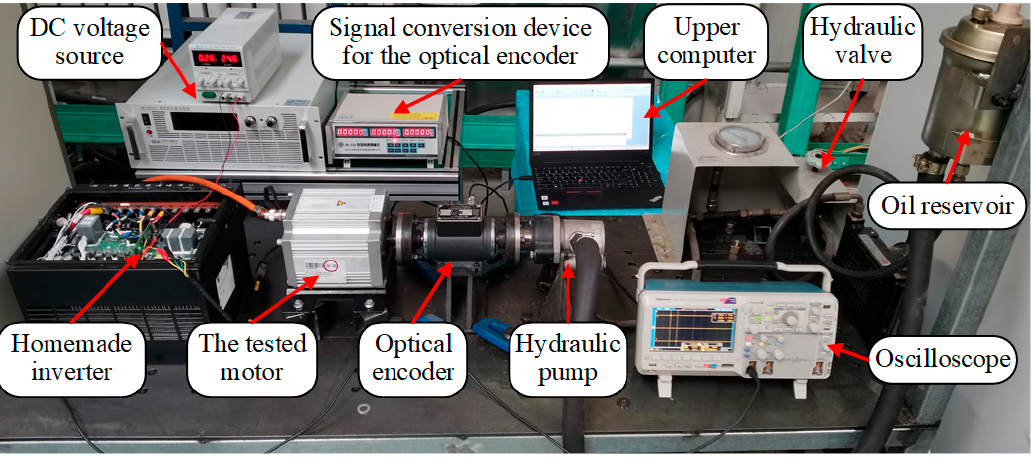
Figure 8. Experimental setup.